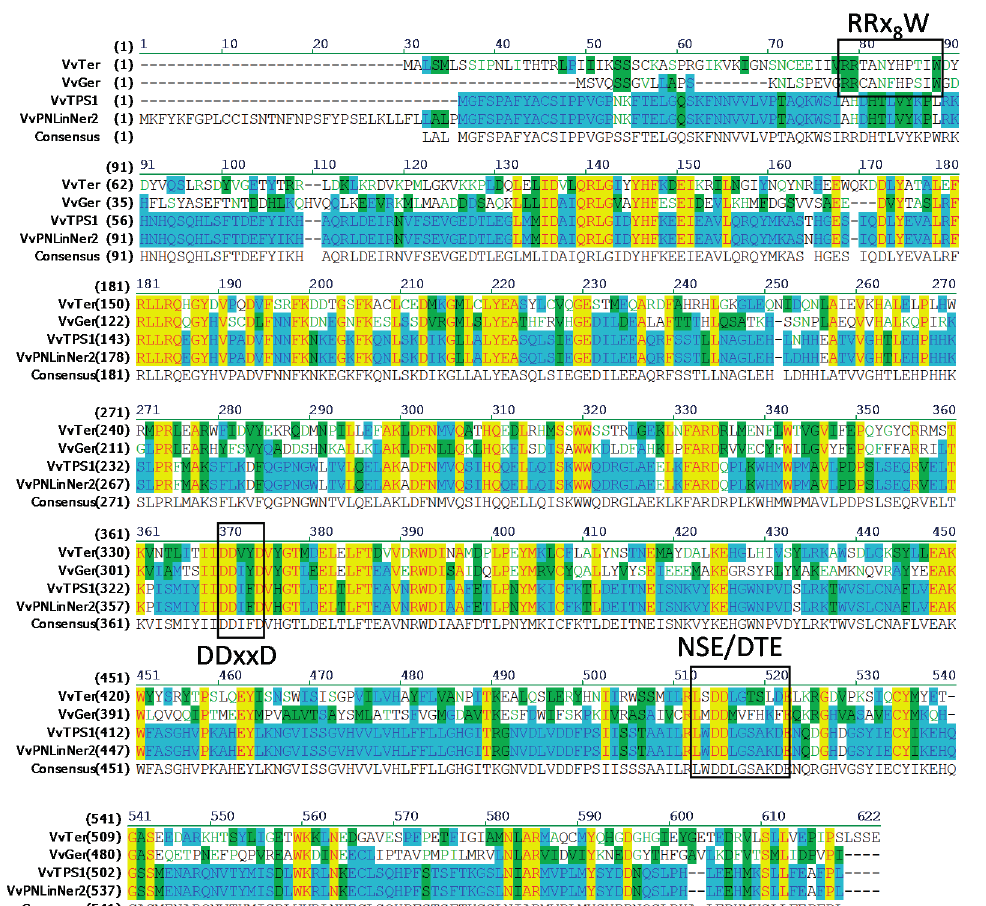
Figure 2. Alignment of the amino acid sequence of VvRiLinNer with other VvTPS. The alignment of VvRiLinNer predicted amino acid sequence with other VvTPS was performed using Align X (Vector NTI Advance 11, Invitrogen). VvTer (GenBank No. AAS79351): ( − )- α -terpineol synthase (Martin and Bohlmann 2004 [25]); VvGerD (GenBank No.Q6Q3H3): ( − )-germacrene D synthase (Lücker et al . 2004 [26]); VvPNLinNer2 (GenBank No. HM807392): linalool/nerlidol synthase, VvCSLinNer (GenBank No. HM807393): linalool/nerlidol synthase (Martin et al . 2010 [14]). Letters in different colors or background colors indicate different degrees of sequence similarity between. Following are the explanations in detail. Letters in black font without the background: nonsimilar; green font without the background: weakly similar; green background: block of similar; blue background: conservative; yellow background: